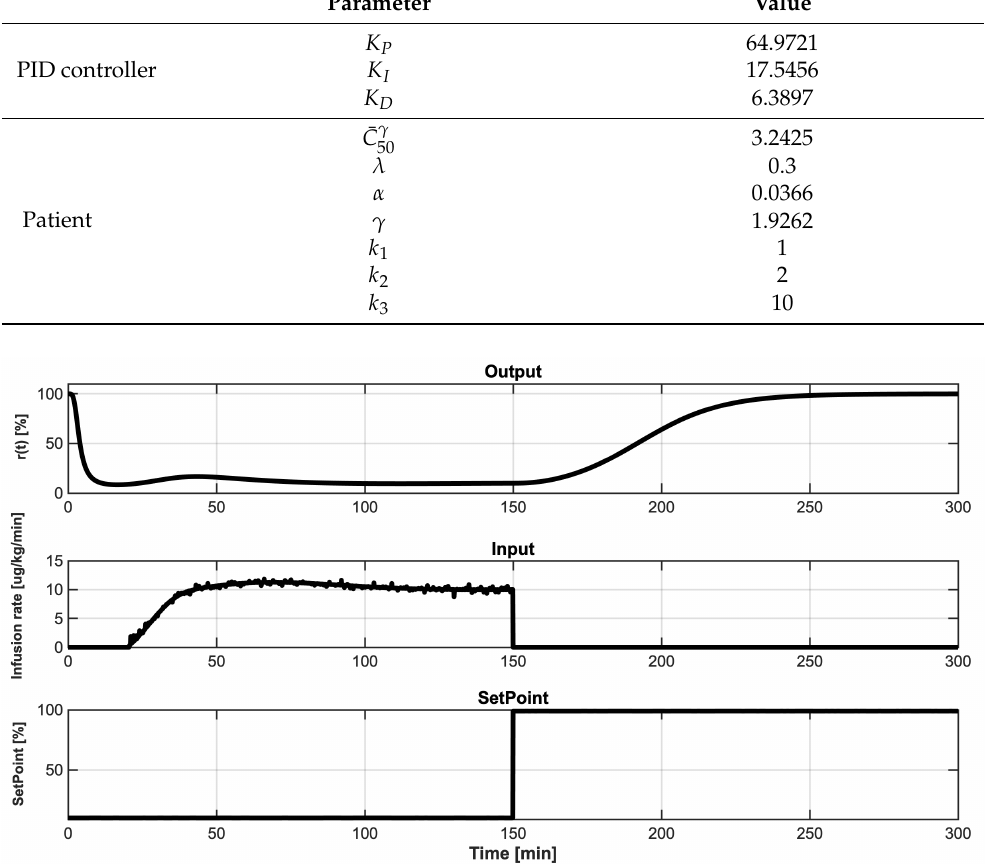
Figure 4. The atracurium infusion rate, u ( t ) , the level of neuromuscular blockade (NMB), and the set point, r ( t ) , in a sample